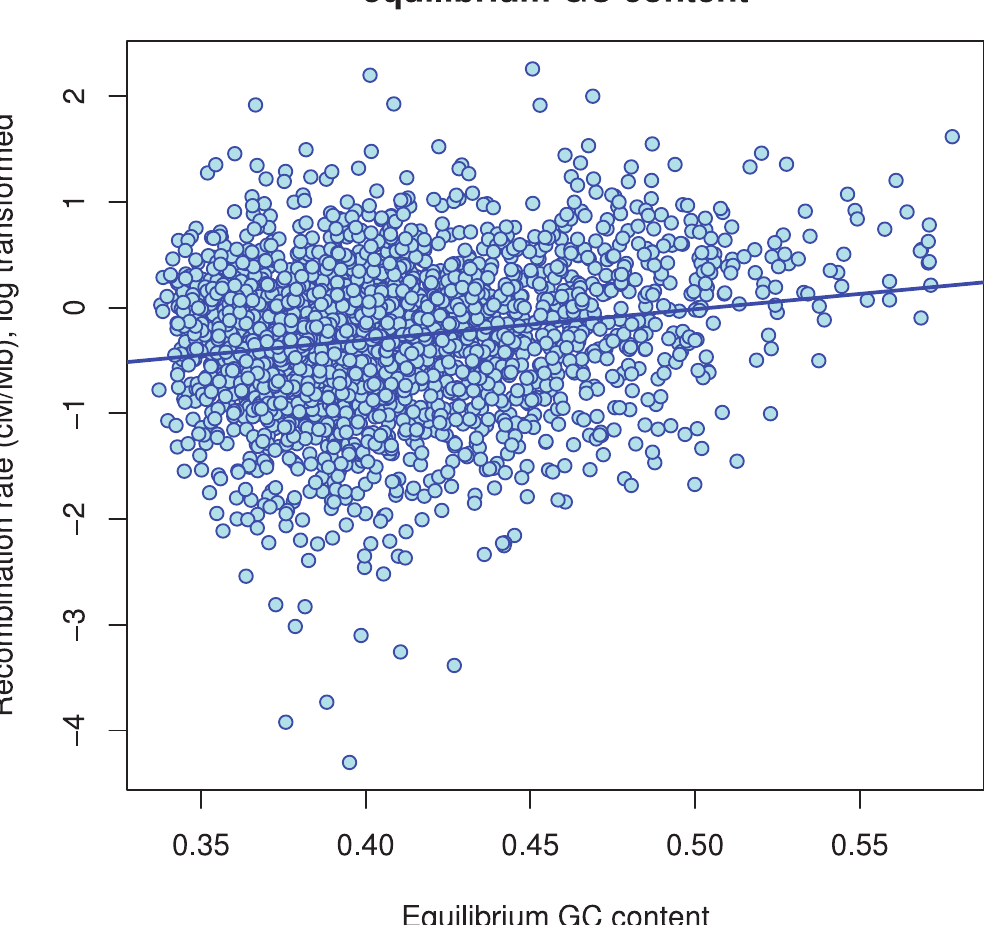
Figure 12. The correlation between GC content and inferred recombination rate. There is a significant positive correlation between recombination rate and (equilibrium) GC content ( r 2 ~ 0 : 03, P v 2 : 10 { 16